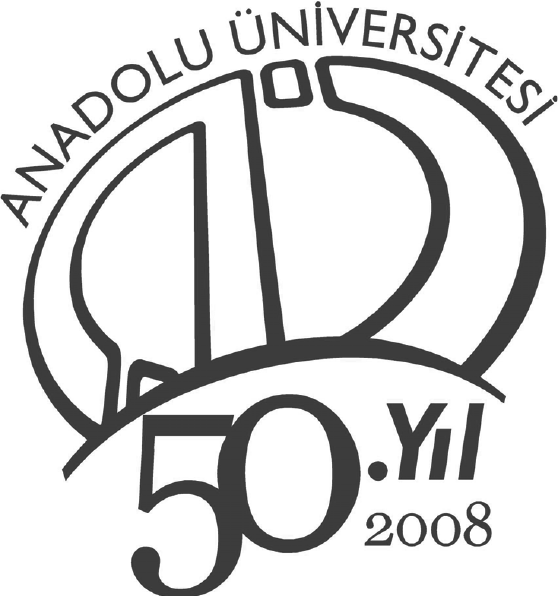
Fig. 1. Anadolu University 50 th Anniversary Emblem and Logotype